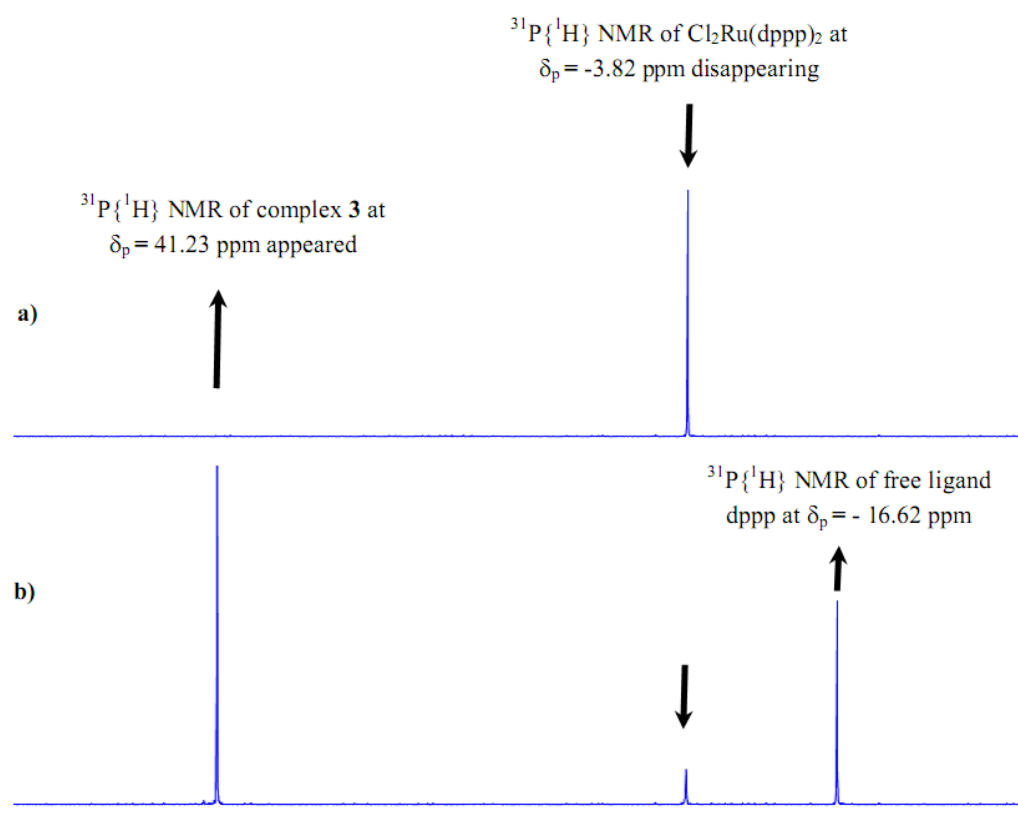
Figure 2. Time-dependent 31 P{ 1 H}-NMR spectroscopic of Cl mixed with two equivalent of 3-(triethoxysilyl)propylamine co-ligand in dichloromethane to produce complex 3 at δ ligand